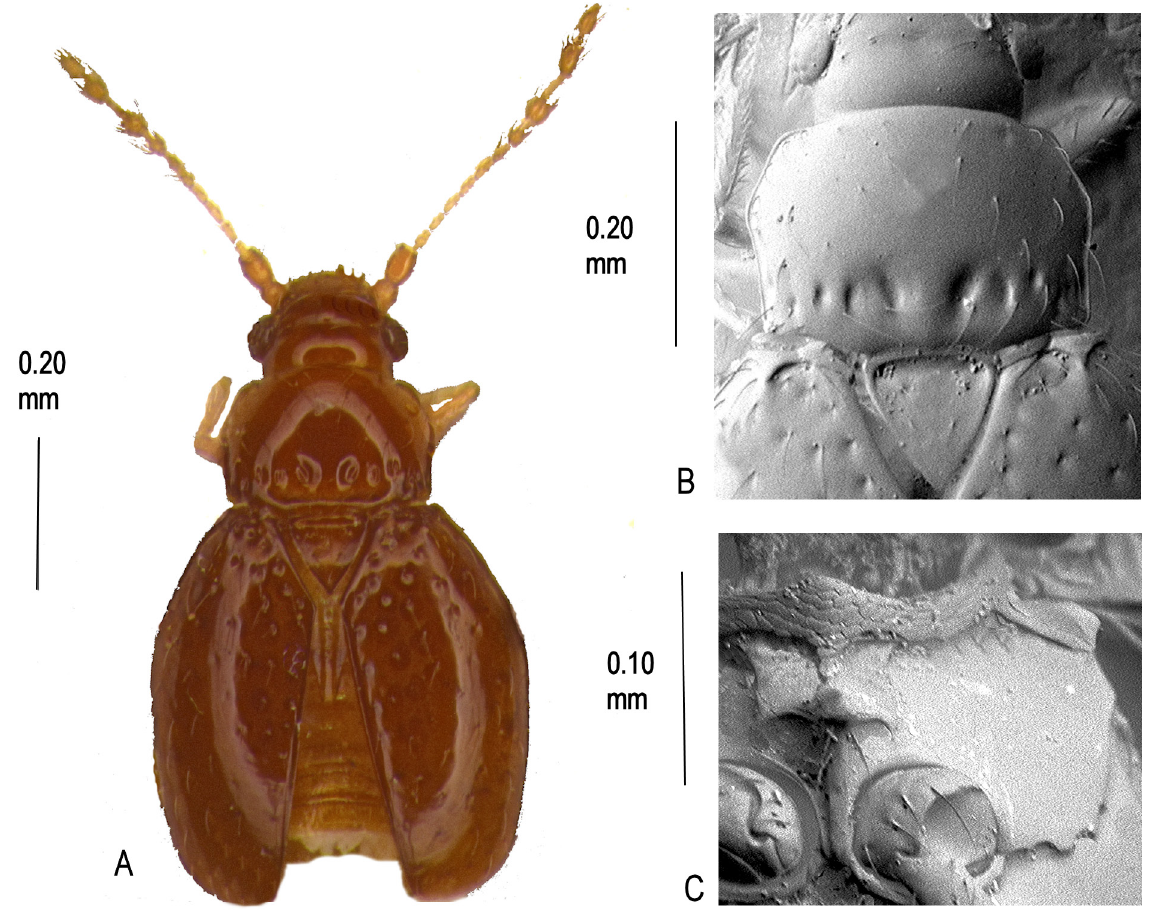
Fig. 15. Cissidium aristophanousi sp. nov. A . Habitus. B . Pronotum, × 370. C . Mesoventrite showing median process of collar, mid-keel, keel and serrate lateral margin,